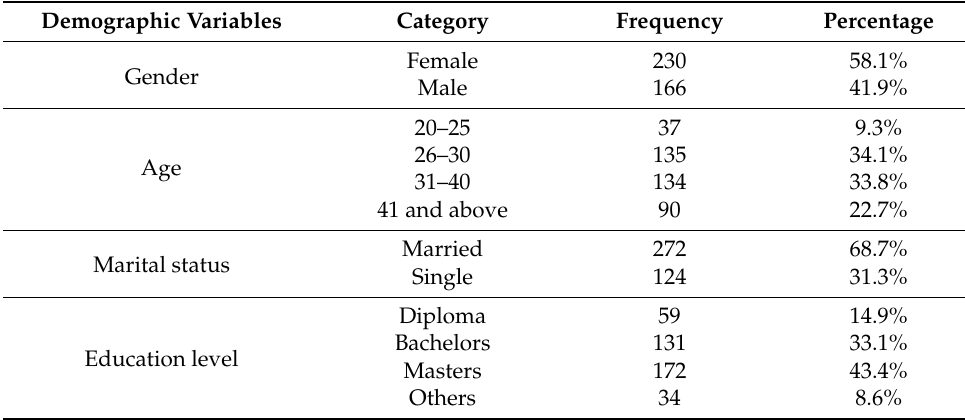
Table 1. Demographic profile of the